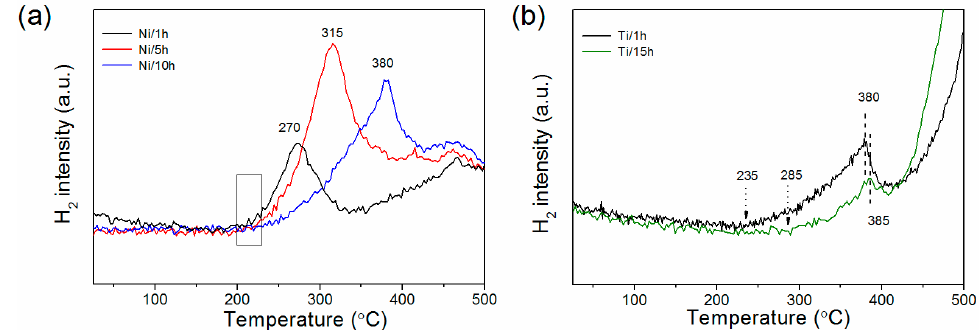
Figure 5. Hydrogen desorption profile of the magnesium nanoparticles deposited on ( a ) Ni and ( b ) Ti. Hydrogenation was carried out at 200 °C and 3 MPa hydrogen pressure. Additional